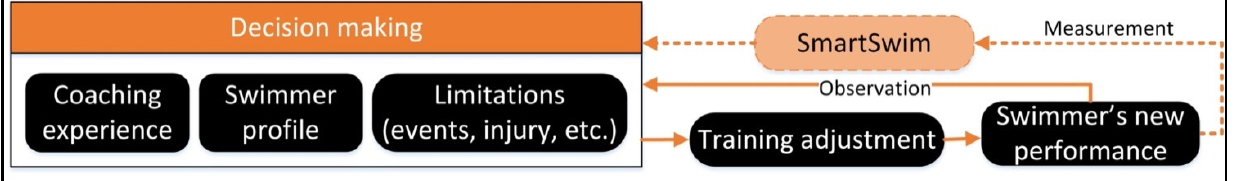
Figure 6. Feedback effect on the training procedure illustrated by the